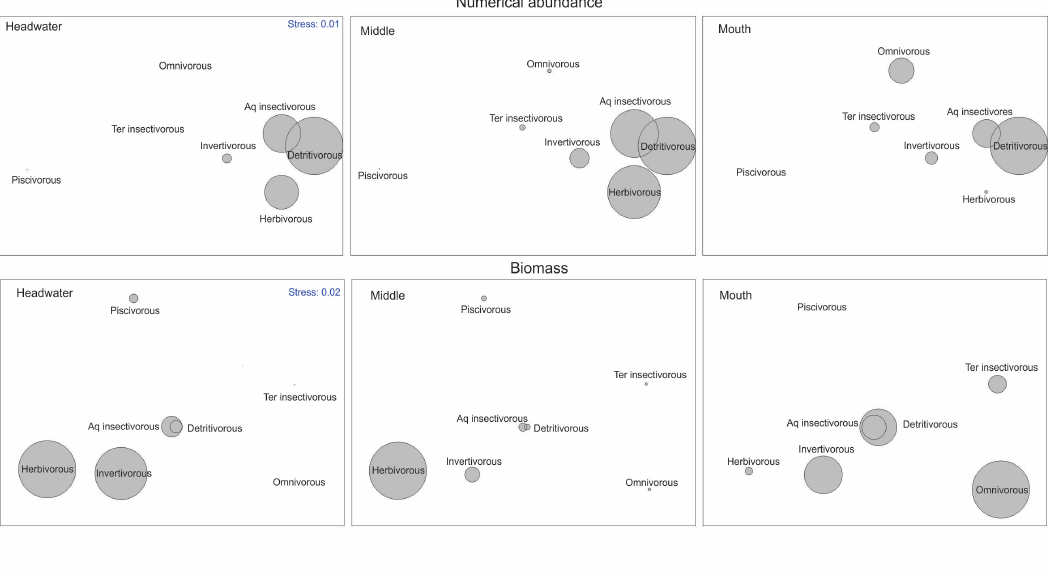
Figure 4. Multidimensional scaling plots of trophic guilds of the Itiz stream. Above the abundance and below the biomass of the guilds showing according to circle size their predominance a long gradient headwater-mouth.